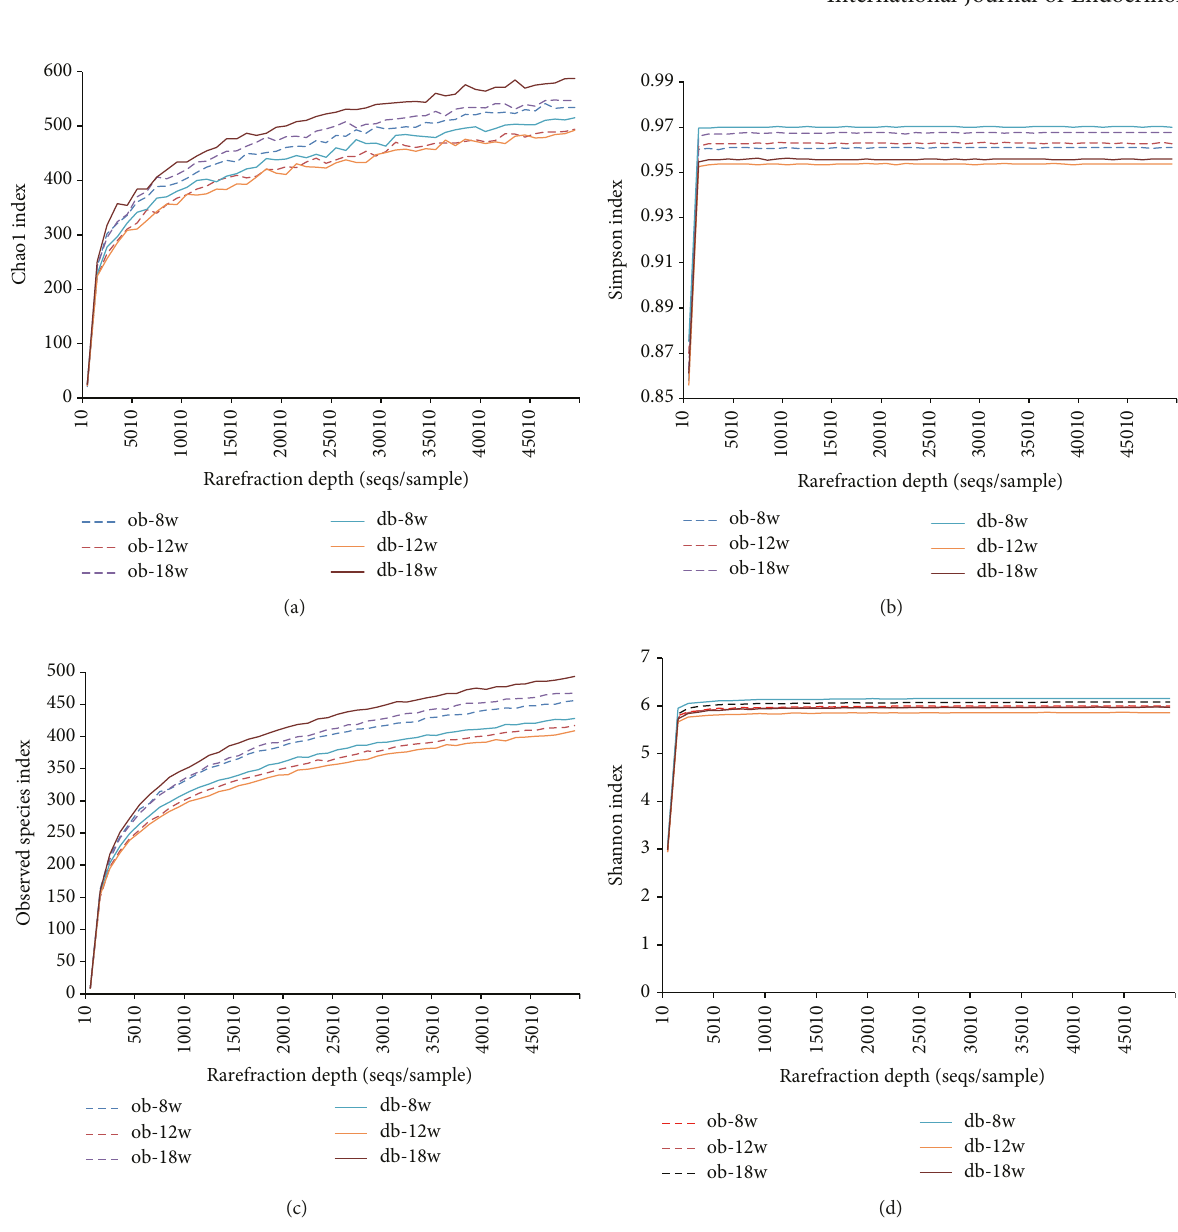
Figure 3: α -Diversity of fecal microbiota in di ff erent groups as shown by Chao1 index (a), Simpson index (b), observed species index (c), and Shannon index